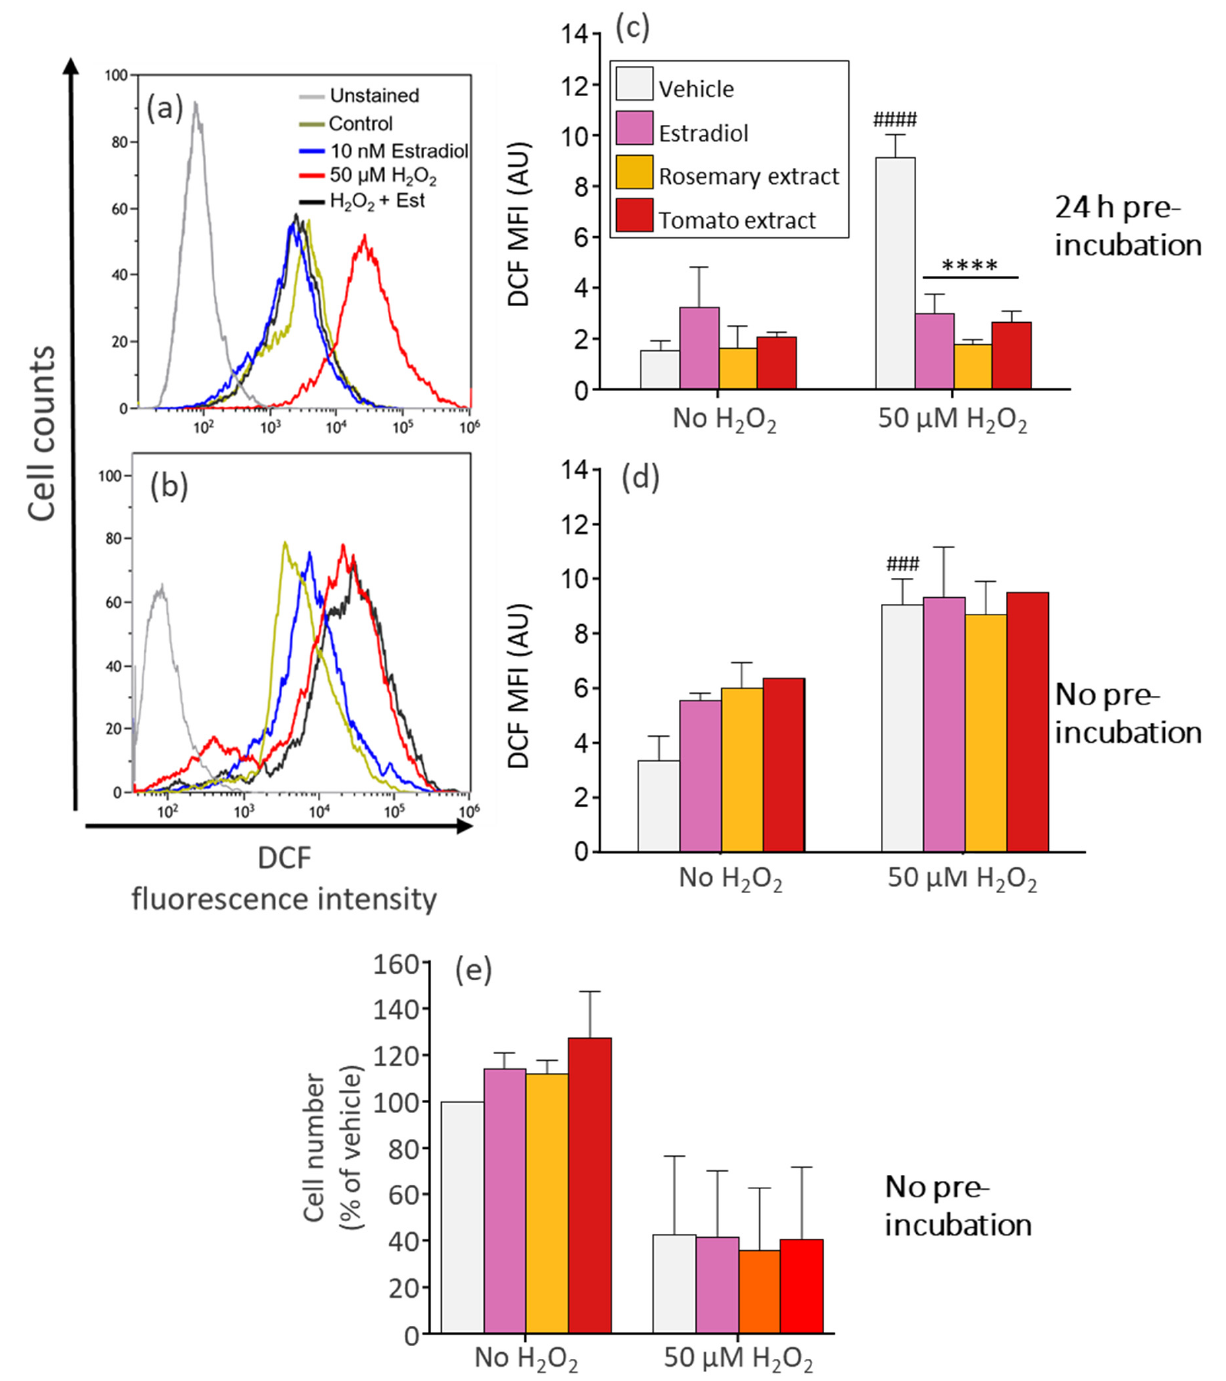
Figure 6. Pre-incubation with the phytonutrients or estradiol is required to reduce H 2 O 2 -generated ROS. Cells were seeded in 6-well plates (3 × 10 5 cells/well) and were pre-incubated for 24 h with ( a , c ) or without ( b , d , e ) estradiol (10 nM), rosemary extract (5 µ M carnosic acid), or tomato extract (10 µ M lycopene). Then, H 2 O 2 (50 µ M) was added together with the treatment compounds, and ROS levels (after 90 min, a – d ) or cell number (after 24 h, e ) were determined as described in Sections 2.3 and 2.5, respectively. ( a , b ) Typical flow cytometric histograms of DCF fluorescence obtained in a representative experiment with ( a ) or without ( b ) pre-incubation. ( c , d ) Averaged geometric means of DCF fluorescence intensities (MFI) with ( c ) or without ( d ) pre-incubation. ( e ) Cell numbers without pre-incubation, 100% of the cell number was 37,858 ± 676 cells/well. Values are the means ± SEM of 2–4 experiments, each performed in duplicate. ### p < 0.001, #### p < 0.0001, significant difference between the vehicle with and without H 2 O 2 . ****, p < 0.0001, significant difference between the vehicle and other treatments in the presence of H 2 O 2 .